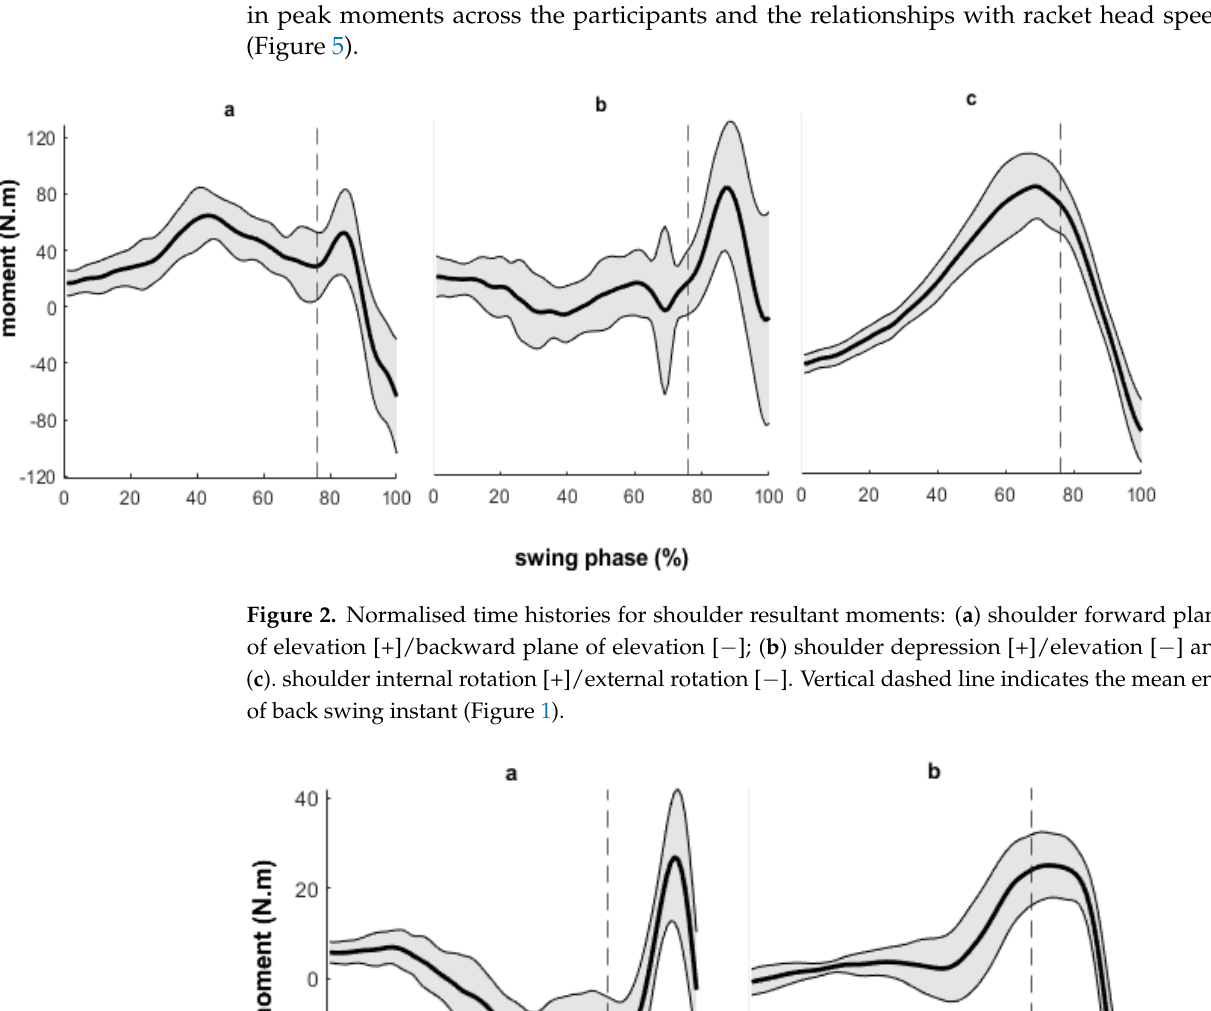
Figure 4. Normalised time histories for wrist resultant moments; ( a ). Wrist flexion [+]/extension [ − ], and ( b ). Wrist ulnar deviation [+]/radial deviation [ − ]. Vertical dashed line indicates the mean end of back swing instant (Figure 1). Individual scatter plots for the three correlated variables, indicating the variation in peak moments across the participants and the relationships with racket head speed (Figure 5).